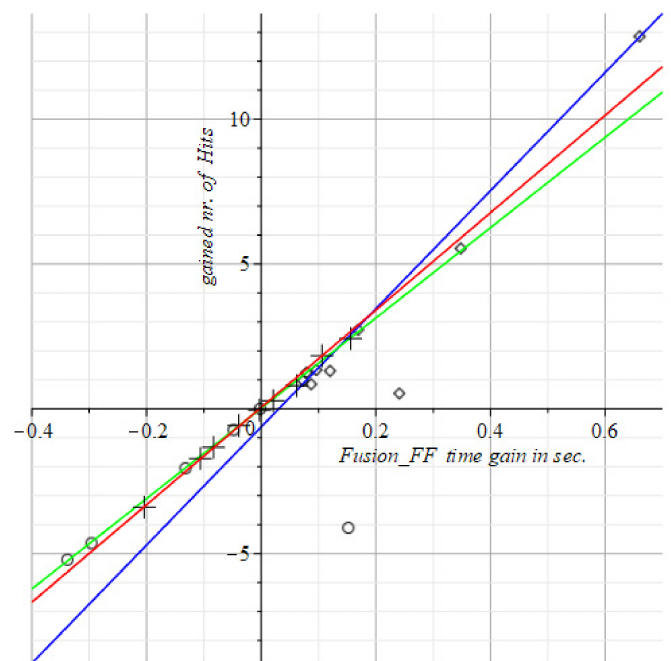
Figure 11. This depicts the results of the Fusion Flexibility test. The control group shows subjects with and without improvement; the motor group’s subjects performance declined while in the visuo- spatial-motor group all subjects show improvement. Circles: Motor intervention, green T 1 = 0.02 ( ± 1.04) + 15.6 ( ± 5.15) T 0 . Rhombus pts: Visuo-spatial-motor intervention, blue T 1 = − 0.63 ( ± 0.67) + 20.4 ( ± 2.4) T 0 . Plus signs: The control group, red T 1 = 0.05 ( ± 0.03) + 16.8 ( ± 0.31) T 0